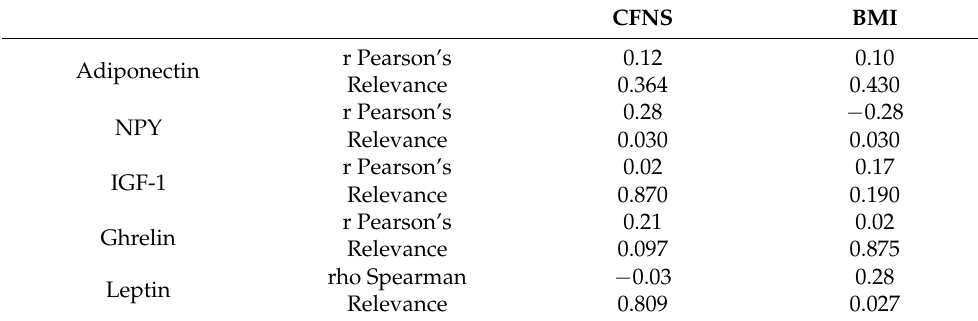
Table 6. Correlation between the serum level of the gut-brain hormonal axis and enteric peptides with CFNS score and BMI (percentile) in participants from the first part of the study.